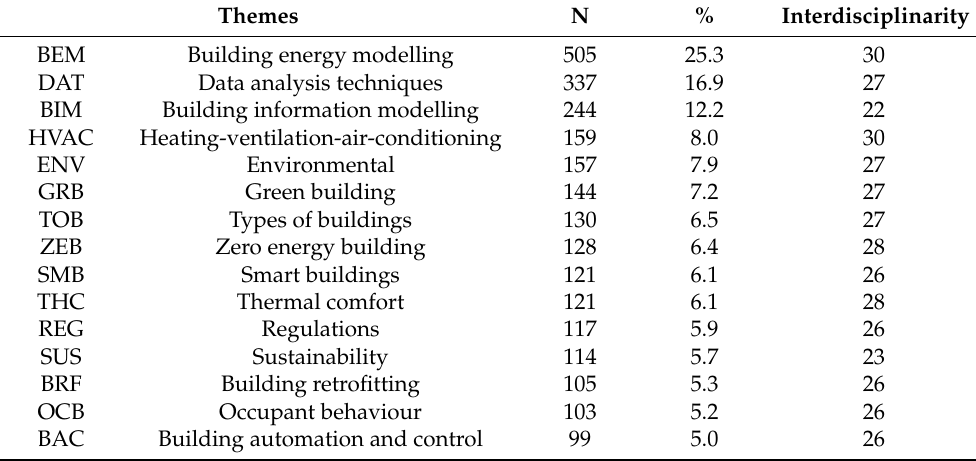
Table 5. The total number of articles dealing with each